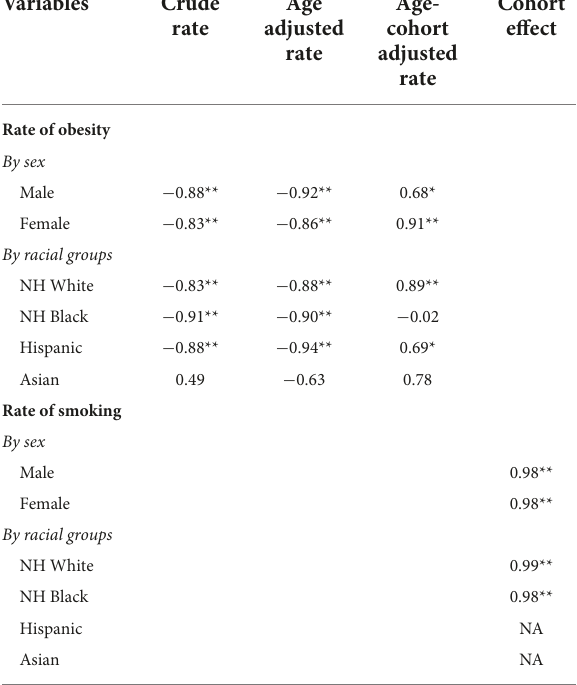
TABLE 1 Correlations (1) between obesity rates and crude rate, age adjusted, and age-cohort adjusted HD mortality rates (1999–2018) and (2) between cohort effects and smoking rates (1965–1990), by sex and racial